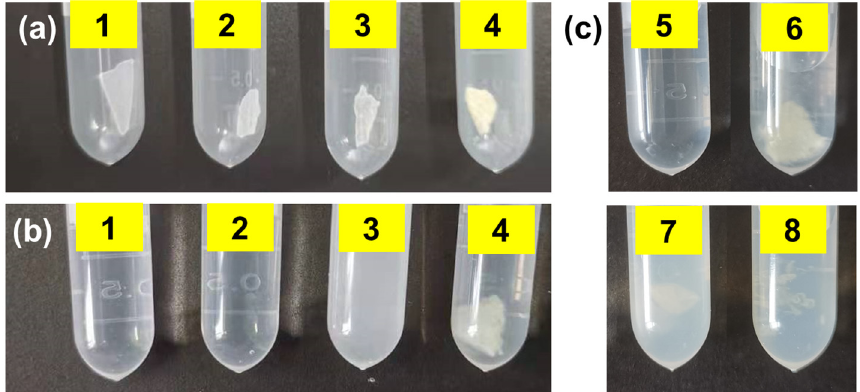
Figure 4. Photographic images of: (1) pure PEG 2k , (2) PEG 2k after irradiation, (3) pristine PEG 2k /GAP ‐ 5 blend, and (4) the PEG 2k /GAP ‐ 5 blend after photo ‐ crosslinking (254 nm, 2 h): ( a ) before immersion in water, and ( b ) immersed in water for 10 min; ( c ) Photographic images of blend samples after photo ‐ crosslinking (254 nm, 2 h): PEG 2K /GAP ‐ 1 (5), PEG 2K /GAP ‐ 5 (6), PEG 4K /GAP ‐ 5 (7) and PEG 20K /GAP ‐ 5 (8) immersed in water for 24 h.